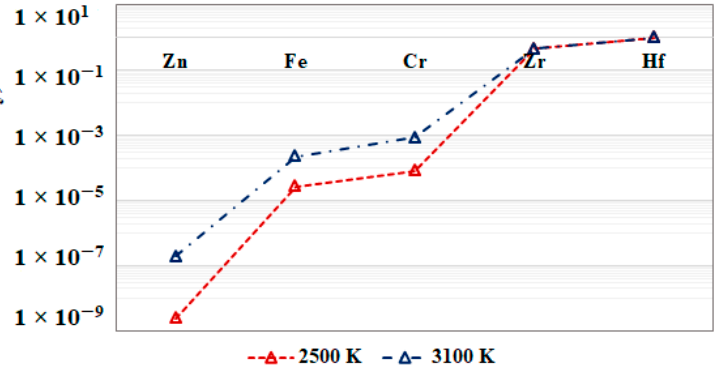
Figure 3. Values of the relative volatility α i for the metal impurities in hafnium at temperatures of 2500 K and 3100 K.